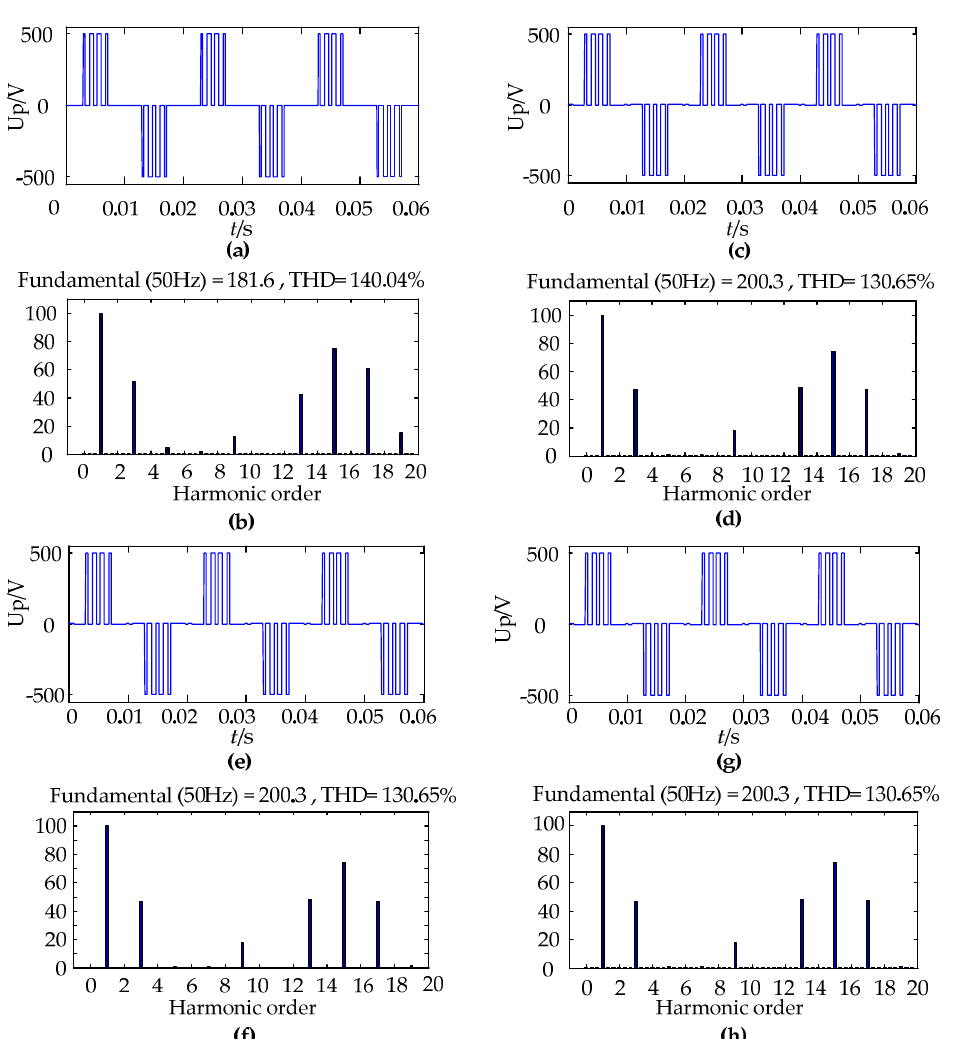
Figure 5. Waveforms of phase voltage and spectrum analysis of four algorithms: ( a , b ) MGA; ( c , d ) PSO; ( e , f ) ICA; ( g , h ) the proposed PSOICA. THD: total harmonic distortion.